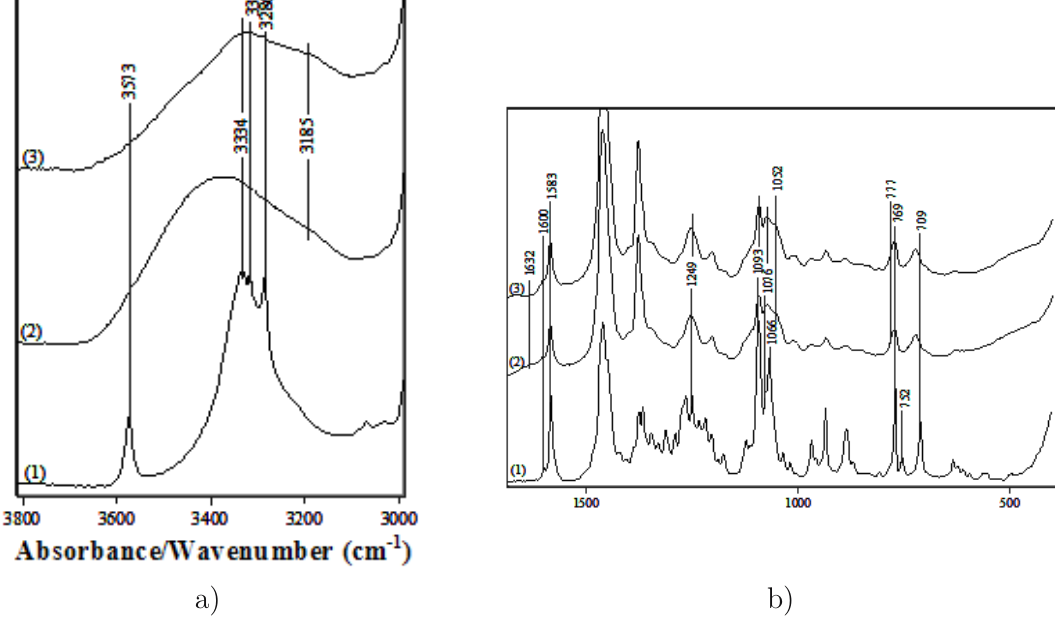
Fig. 4 Solid-state FT-IR-spectra of nadolol (curve 1) and its dinuclear Cu(II)-complex, 3 (curve 2); reduced FT-IR-spectrum of 3 (curve 3) after elimination of δ H 2 O at 1632 cm − 1 assigned to water scissoring